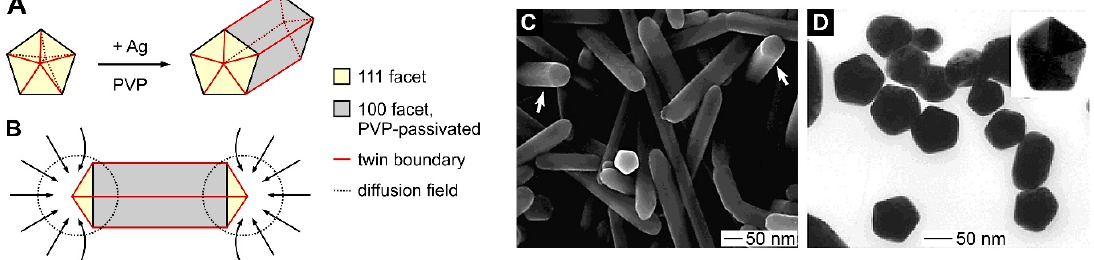
Figure 1. ( A ) Formation mechanism of pentagonal Ag nanowires, starting from fivefold twinned, decahedral, {111}-faceted seed nanoparticles, which elongate during growth due to the passivation of the evolving {100} facets by polyvinylpyrrolidone (PVP). ( B ) Schematic side view of a growing nanowire, indicating the selective deposition of metal at the nanowire tips. ( C ) Scanning electron microscopy (SEM) image of Ag nanowires, in which the angular tips of some nanowires are highlighted. ( D ) Transmission electron microscopy (TEM) images of microtomed nanowires, corroborating their pentagonal cross-section. Reprinted (adapted) with permission from [31]. Copyright (2003) American Chemical Society.